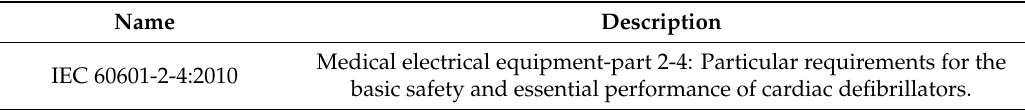
Figure 2. Experimental equipment and setting. ( ① Automated External Defibrillator (AED) ② Oscilloscope ③ AED JIG). Table 1. Electric shock energy test application Table 1. Electric shock energy test application standard.